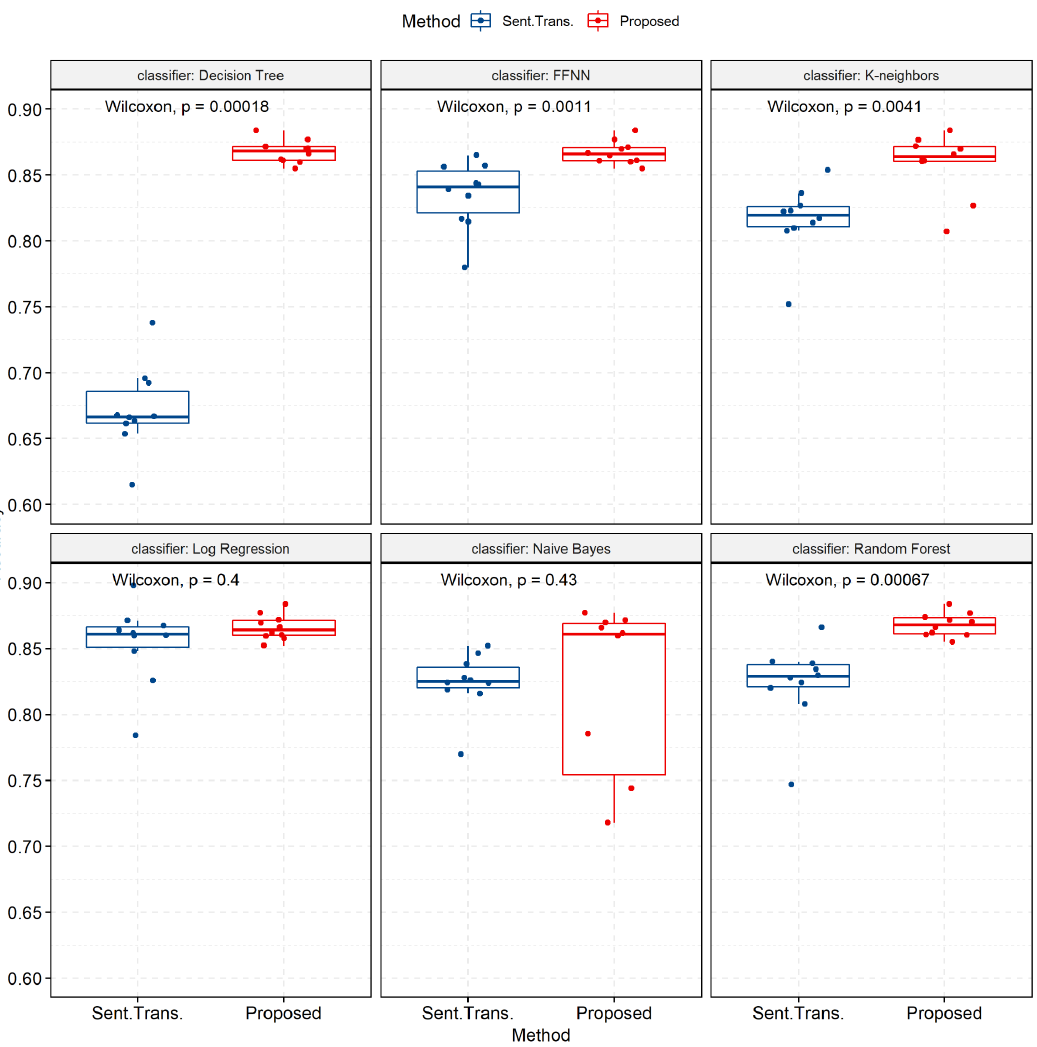
Figure 8. Results of statistical significance testing using non-parametric Wilcoxon test. Boxplots show an accuracy of classification using sentence transformers (Sent. Trans.) and the proposed method.